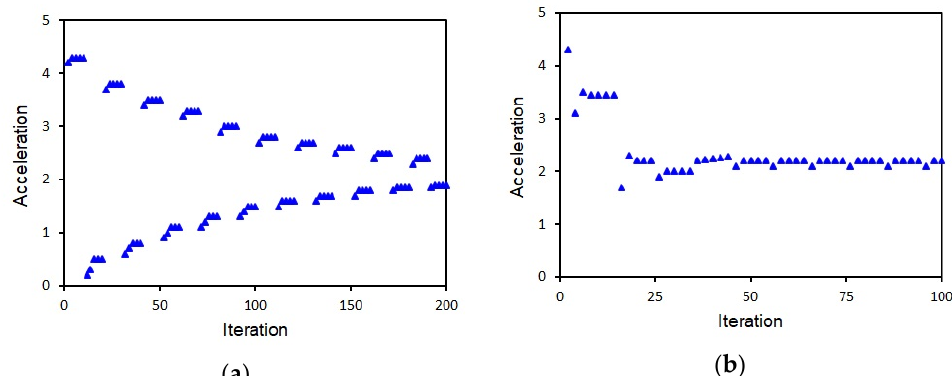
Figure 2. Convergence characteristics of explicit and implicit solvers: ( a ) Symplectic solver (explicit); ( b ) Newmark solver (implicit).